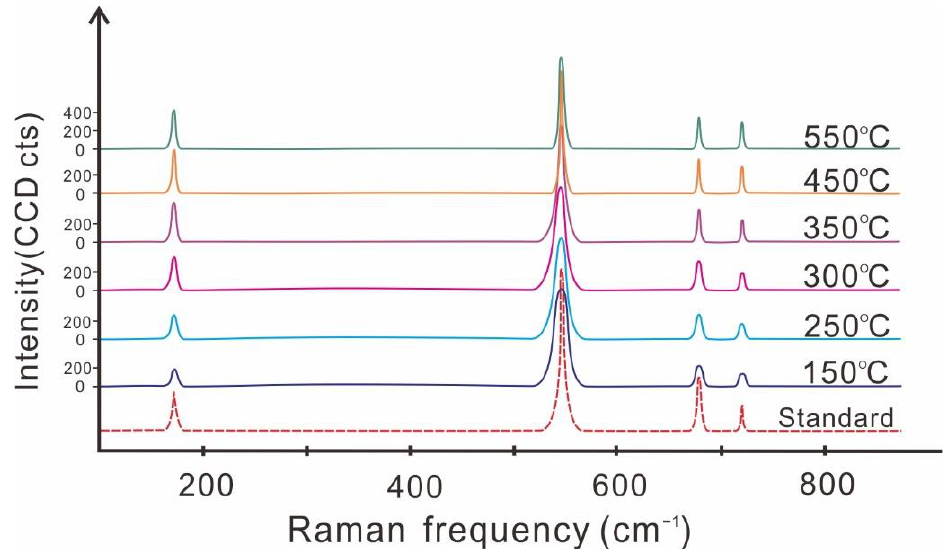
Figure 2. Raman spectra of OsO 2 in the present study and typical OsO 2 crystals. The standard Raman spectrum of OsO 2 is derived from Yen, et al. [32].